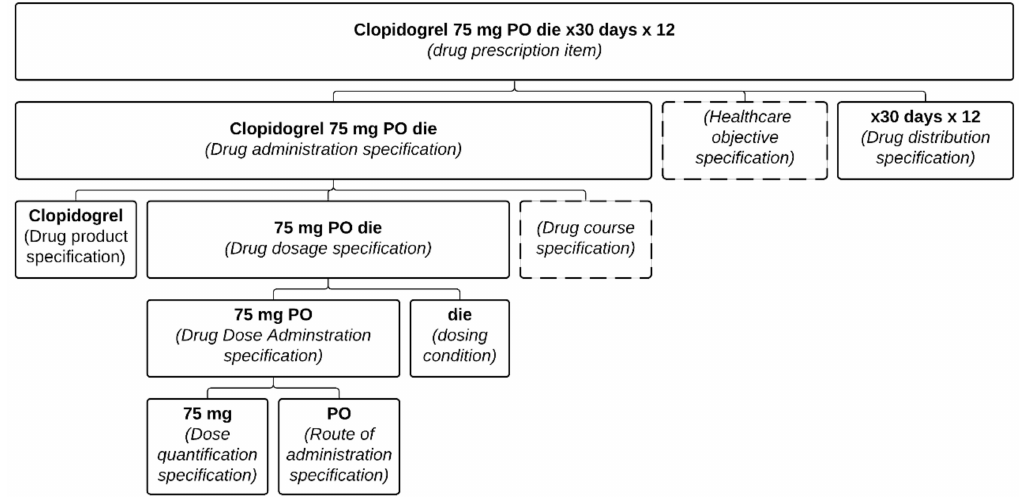
Figure 4. Representation of the prescription item presented in the Clopidogrel example formalized in the PDRO ontology. Each part of the prescription item is associated with its relevant